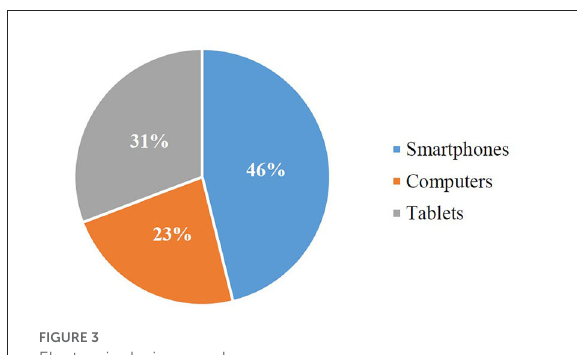
FIGURE3 Electronic devices